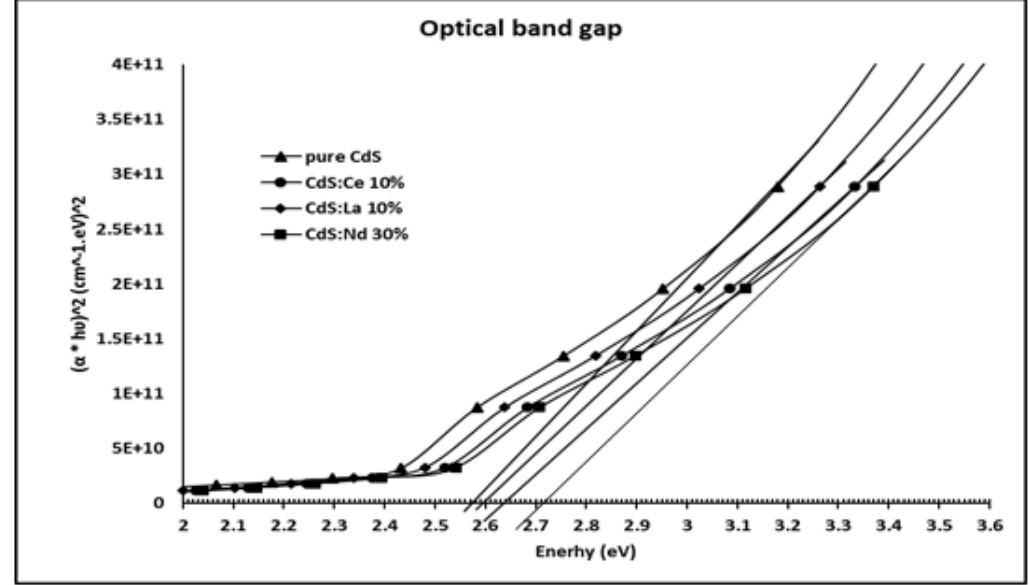
Fig.4: The optical band gap for pure CdS and (Ce, La and Nd) doped CdS at 10